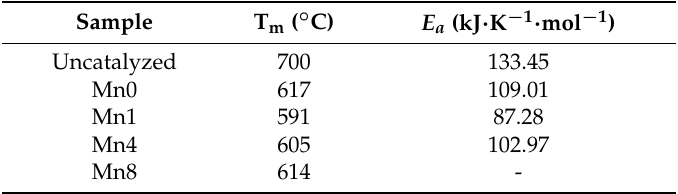
Table 3. T m and activation energy for the catalysts synthesized in this work during the soot catalytic